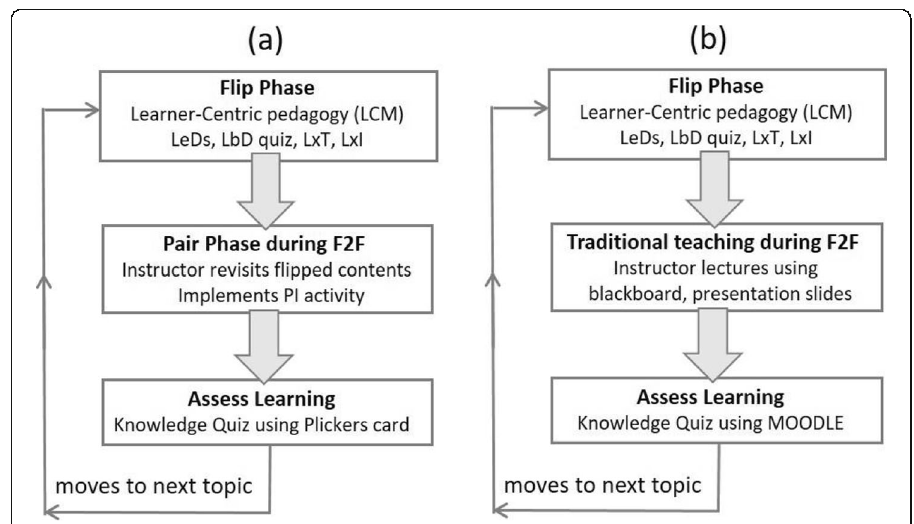
Fig. 5 Instructional flow of ( a ) Flip & Pair (F&P) and ( b ) Flip & Traditional Teaching (F&TT)